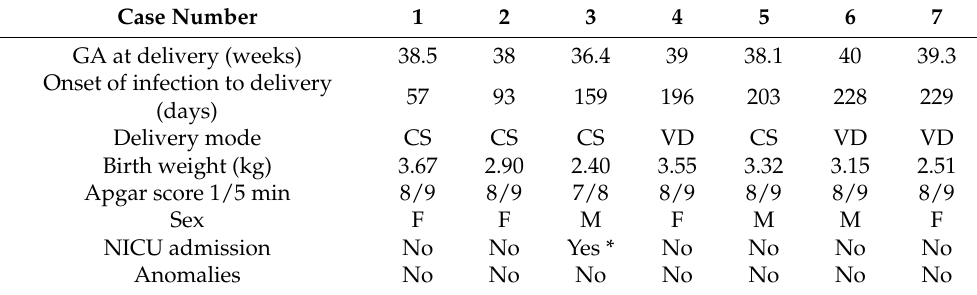
Table 3. Neonatal